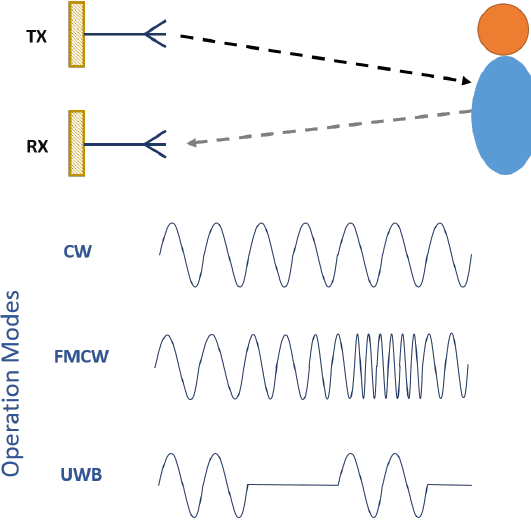
Figure 1. Doppler radar applied to vital-signs acquisition, using different operation